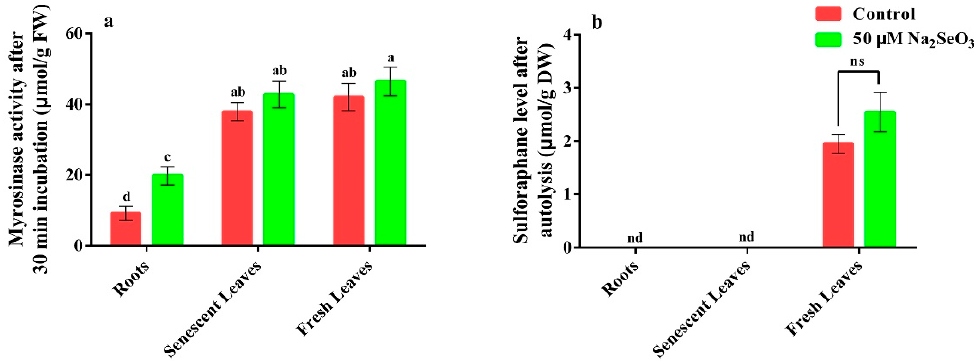
Figure 3. Effects of Se on MYR activity and sulforaphane level after autolysis. ( a ) MYR activity in different tissues of broccoli under control and 50 μ M Na 2 SeO 3 treatments. ( b ) Sulforaphane level after autolysis in broccoli tissues under control and 50 μ M Na 2 SeO 3 treatments. Data with different lower-case are significantly different at p < 0.05. ns means no significant difference at p > 0.05 by t testing.